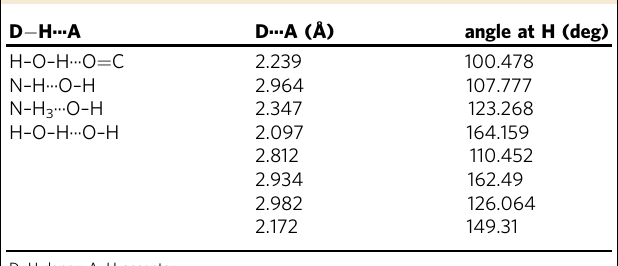
Table 1 Hydrogen Bond Parameters for 0D lead bromide hybrids D −